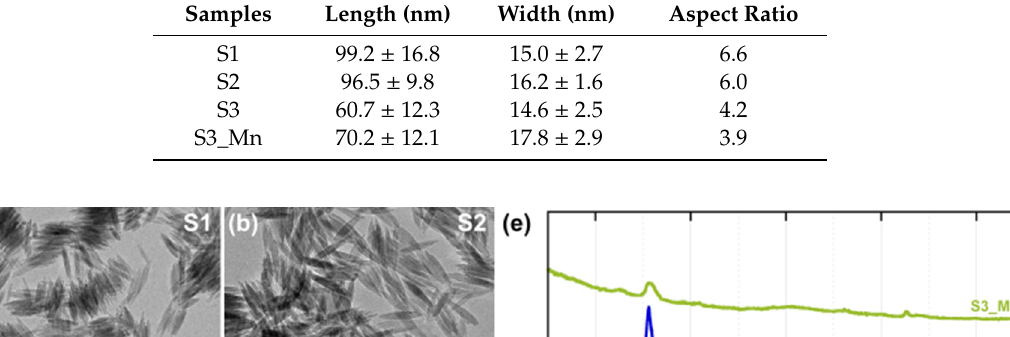
Table 1. Sample dimensions. The nanocrystallite sizes were calculated by the conventional TEM imaging.